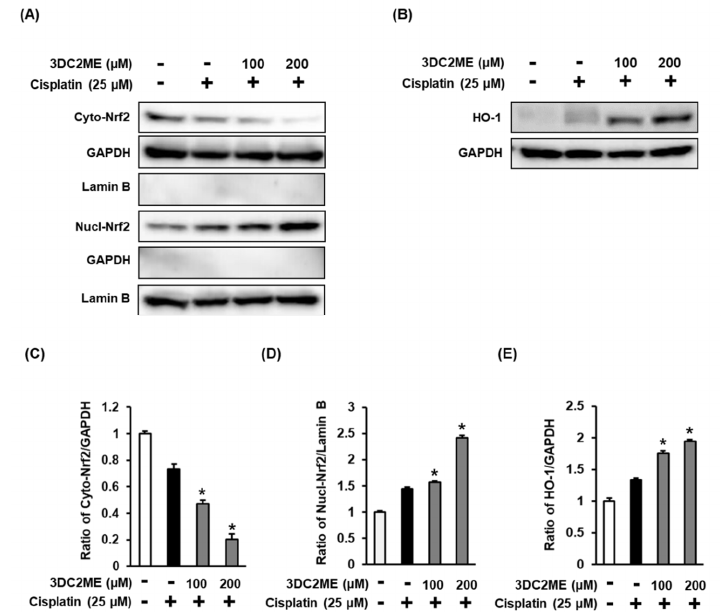
Figure 3. Effects of 3DC2ME and/or cisplatin on the expression of heme oxygenase 1 (HO-1)/nuclear factor erythroid 2-related factor 2 (Nrf2) proteins associated with antioxidant pathways in LLC-PK1 cells. ( A , B ) LLC-PK1 cells were exposed to 25 μ M cisplatin in the presence or absence of 100 or 200 μ M 3DC2ME, and western blot analysis was performed using antibodies for Nrf2, HO-1, lamin B, and GAPDH. ( C – E ) The ratios of nuclear Nrf2, cytosolic Nrf2, and HO-1 compared with the control cells are represented as bar graphs (mean ± SD, * p < 0.05 cisplatin-treated LLC-PK1 cells).